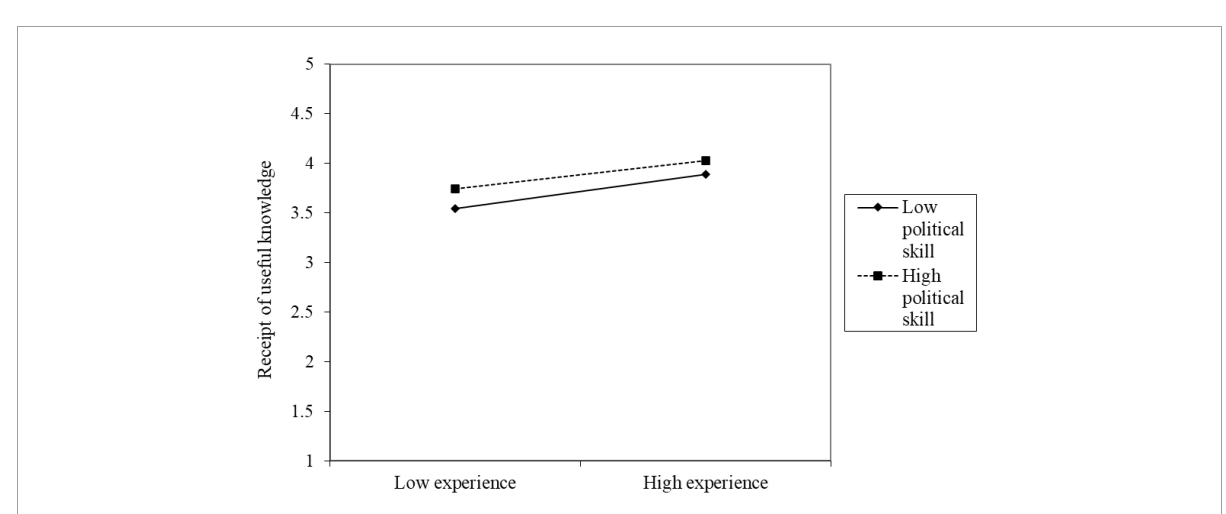
FIGURE5 Diagram of the interaction of political skills affecting experience on receipt of useful